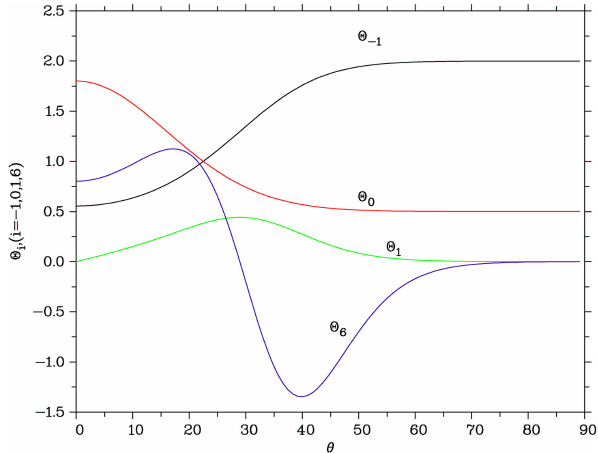
Fig. 1. Shown are the following θ dependent normalized functions: The black curve ( 2 − 1 ) represents the latitudinal dependence of the solar wind speed, while the red curve ( 2 0 ) represents that of the solar wind number density. The green curve is the function 2 1 , and the magenta curve is the function 2 6 , both of which are used in the solutions of the differential equations. 2 1 and 2 6 are the first and second derivative with respect to θ of 2 − 1 = V r (θ)